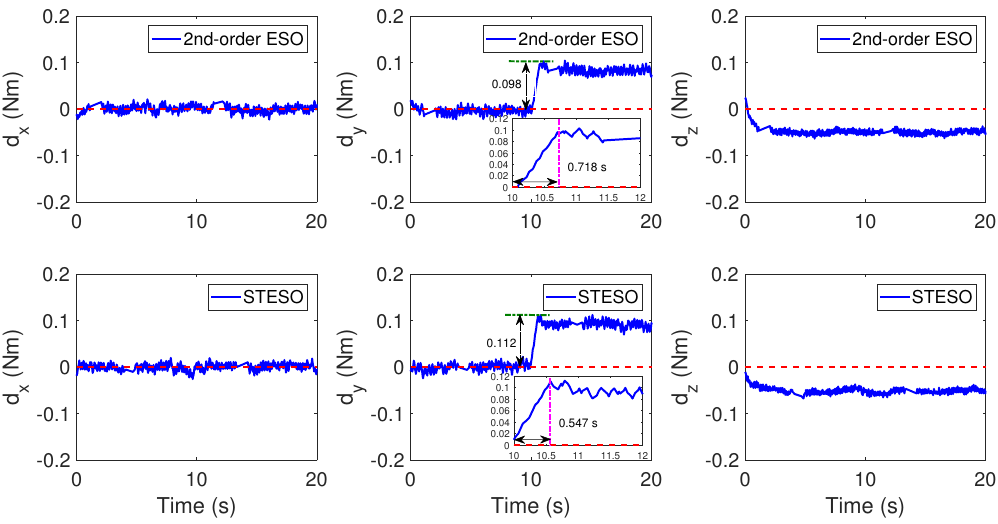
Figure 11. Disturbance estimation results of different DUE with actuator faults in Case A. Table 2. Comparison of control performances with different observers. Deflection Recovery